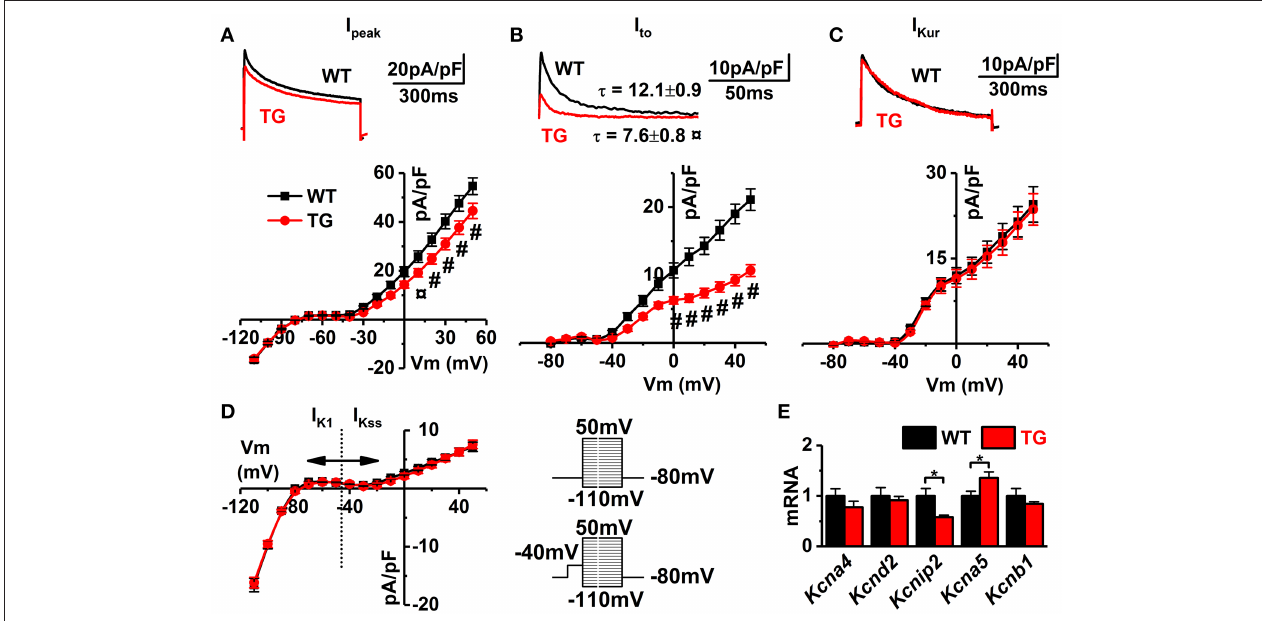
FIGURE 6 | Voltage-gated potassium currents. Representative superimposed original traces (upper, obtained at + 50mV) and I–V curves (lower) of (A) total potassium (I peak ), (B) transient outward (I to ), and (C) ultra-rapid (I Kur ) currents. (D) I–V curves of K1 and steady state currents (I K1 /I Kss , WT black and TG red lines, WT n = 8 and TG n = 17; from four animals). Refer to insets for voltage-step protocols (upper without and lower with inactivation prepulse). (E) Gene expressions of potassium channel subunits (WT n = 7 and TG n = 6). * P < 0.05, ¤ P < 0.01 and # P < 0.001.